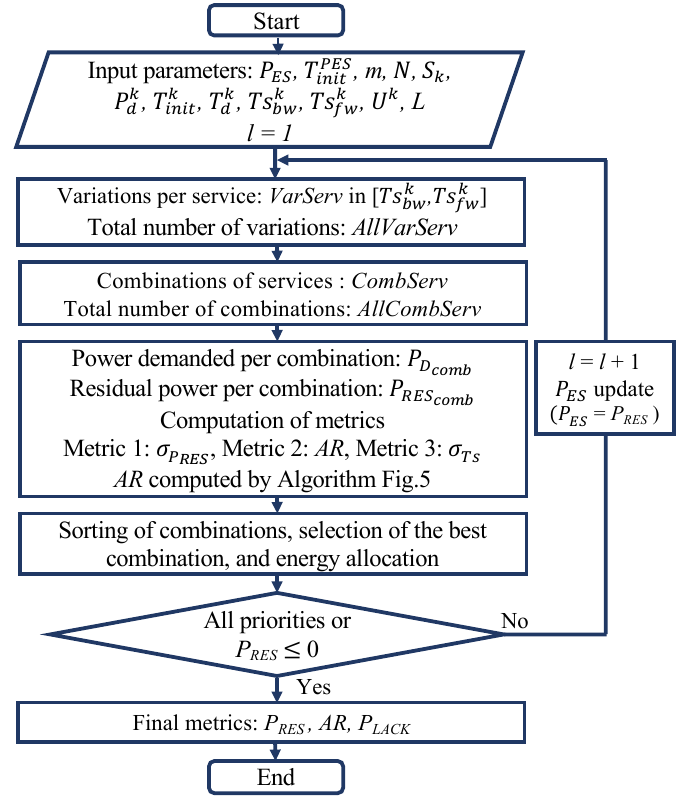
Figure 6. Flow chart of the exact scheduling